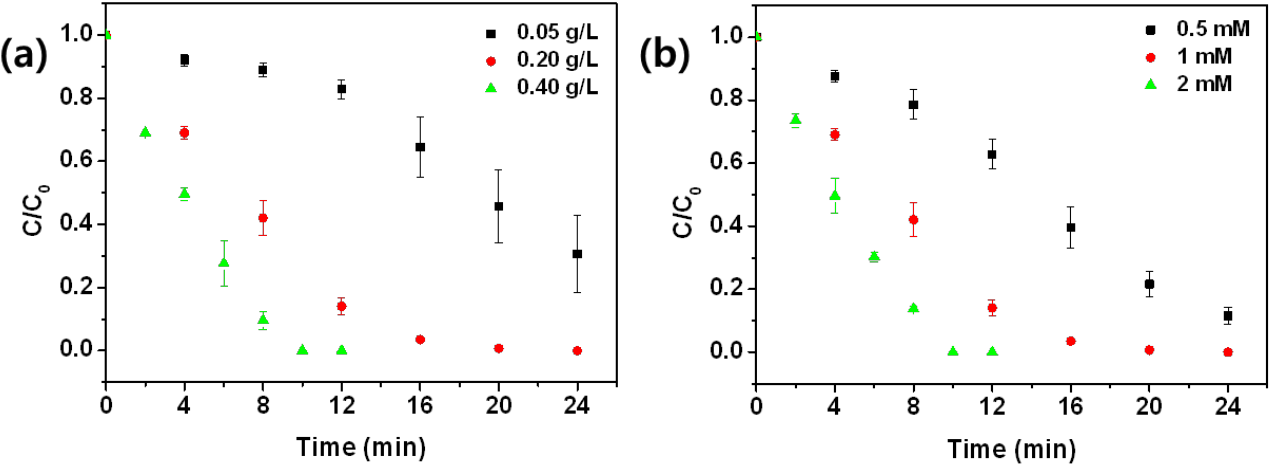
Figure 6. Oxytetracycline (OTC) degradation with ( a ) different catalyst dosages and ( b ) different persulfate concentrations ([OTC] 0 = 20 μ M).